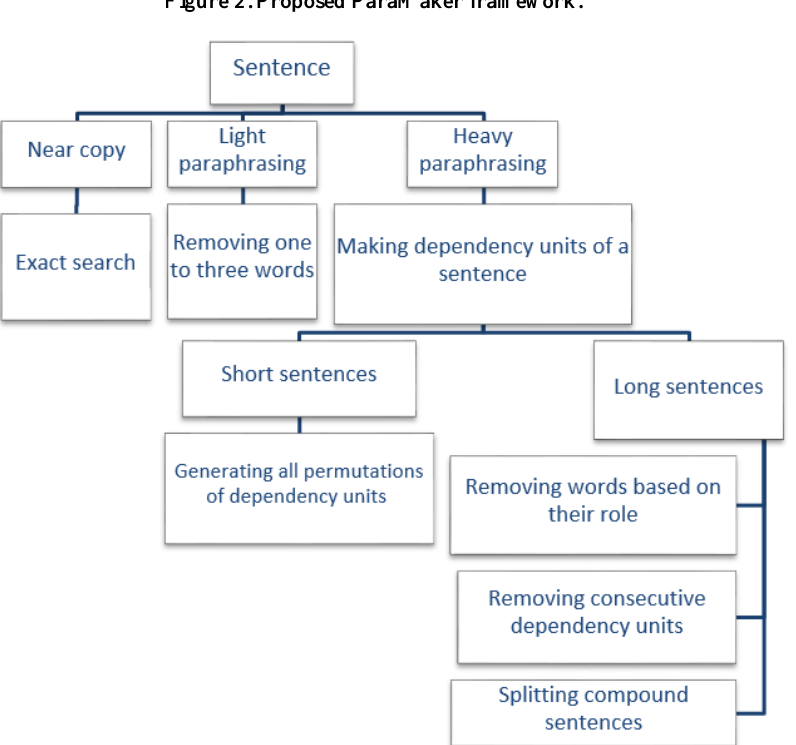
Figure 2. Proposed ParaMaker framework.